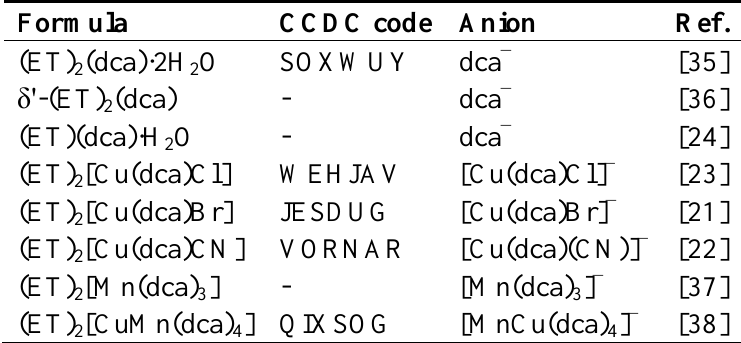
Table 3. ET salts with the dicyanamide (dca) anion.